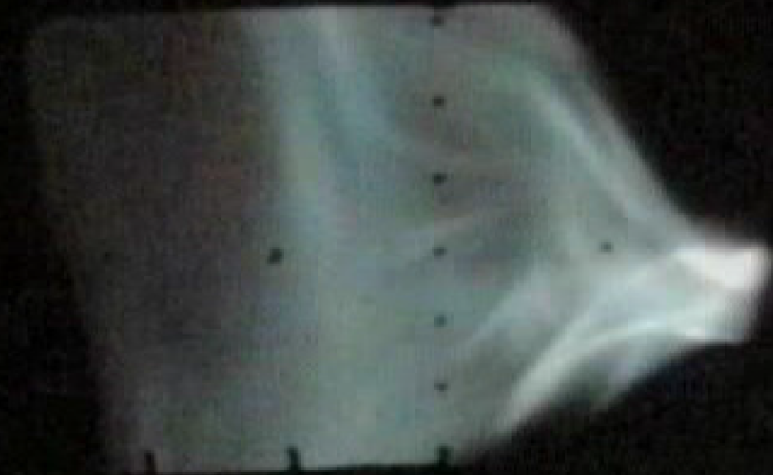
Figure 6. Profile of the beam from Figures 4 and 5 behind a dipole shows an even more complicated structure in the intensity distribution. Only one m / q is visible here. Lower momenta appear on the left side. The question arises: how does one explain the visible structure? Are there three lines visible, or even